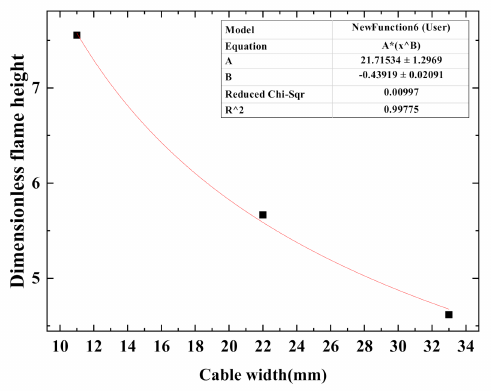
Figure 8. The relationship between the dimensionless flame height and the cable